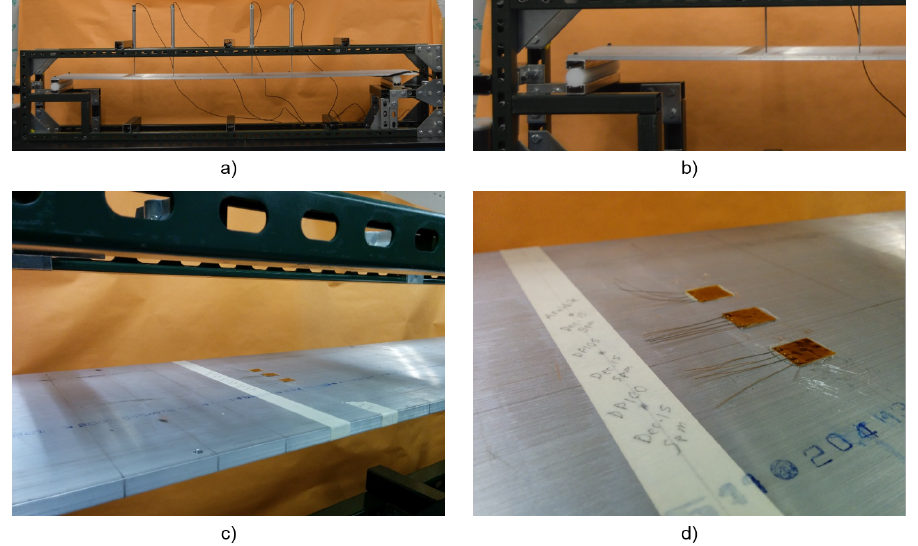
Figure 7. Strain transfer test set-up: ( a ) view of beam without sensors; ( b ) support detail; ( c ) view of sensors installed using Araldite 2012, 3M DP 100, and 3M DP 105; ( d ) sensor